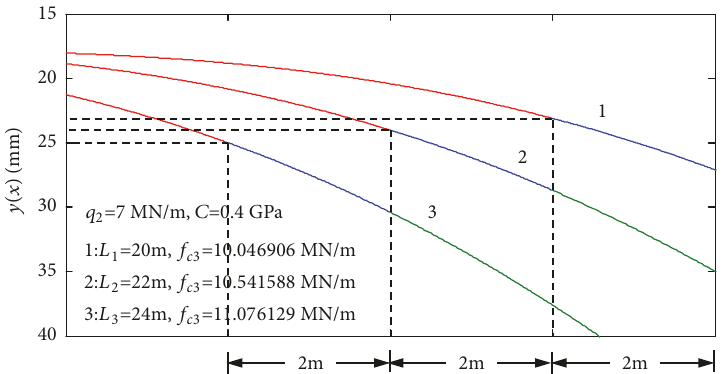
Figure 13: Enlarged drawings of rock beam deflection curves at the junction between elastic area and hardening area of coal seam.